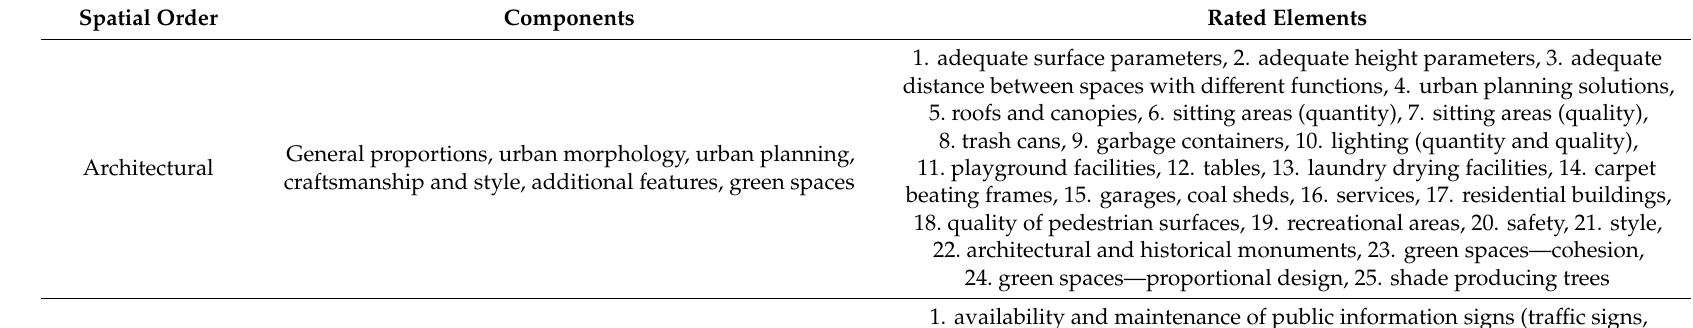
Table 1. Domains and components of spatial order for evaluating the quality of public spaces. Source: own elaboration based on